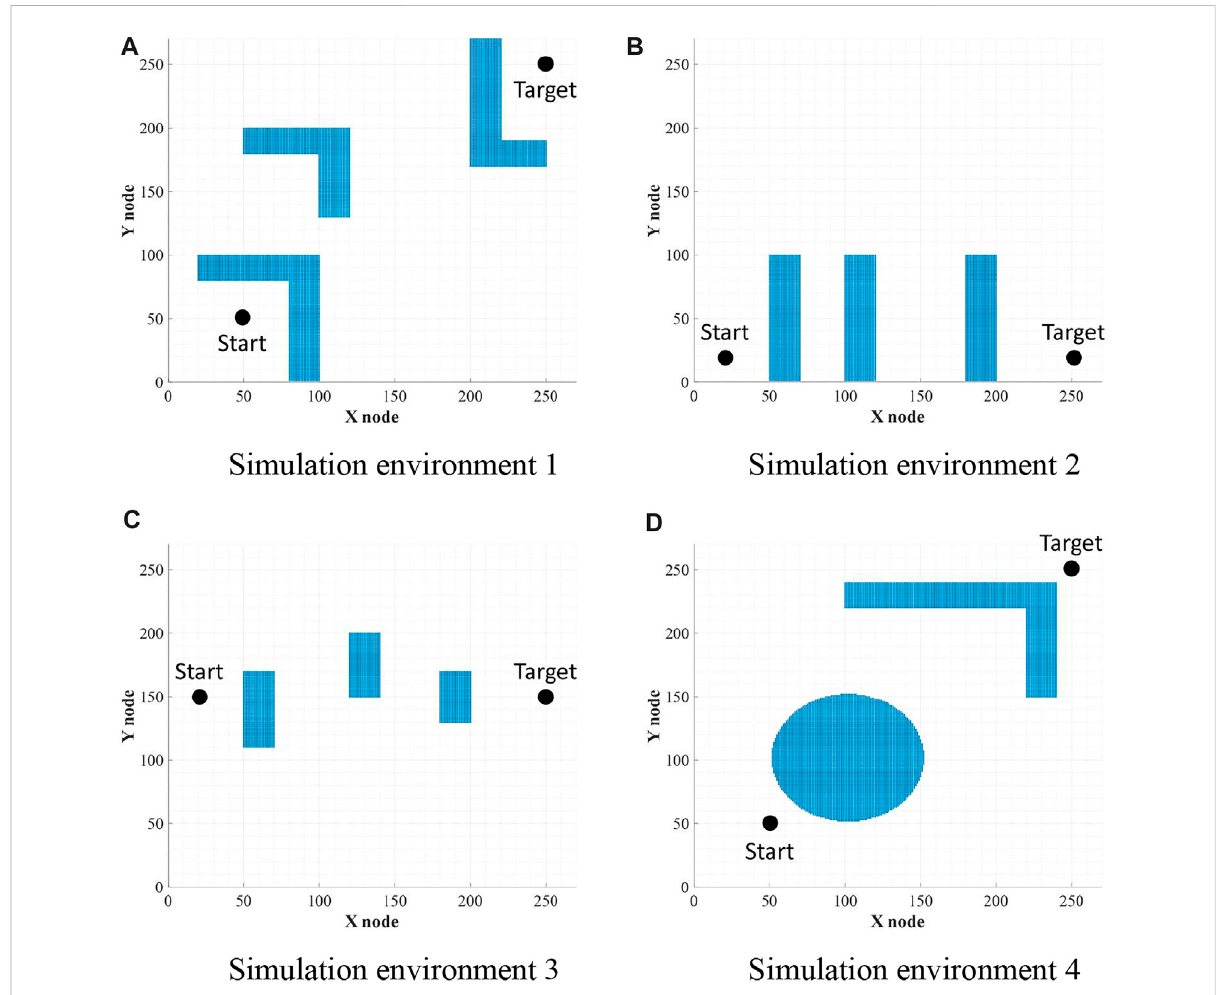
FIGURE 10 Environments for simulations. (A) Simulation environment 1. (B) Simulation environment 2. (C) Simulation environment 3. (D) Simulation environment 4.